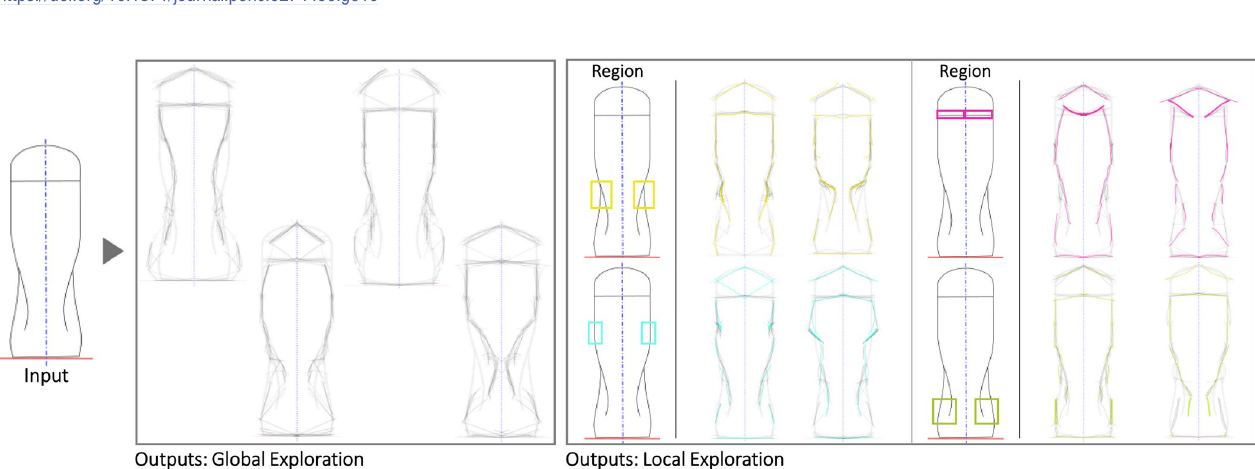
Fig 11. Some of the Global and Local shape variations generated with Shapi for the conceptual exploration of a water bottle. The Seed is based on an exploration by a product designer [90].